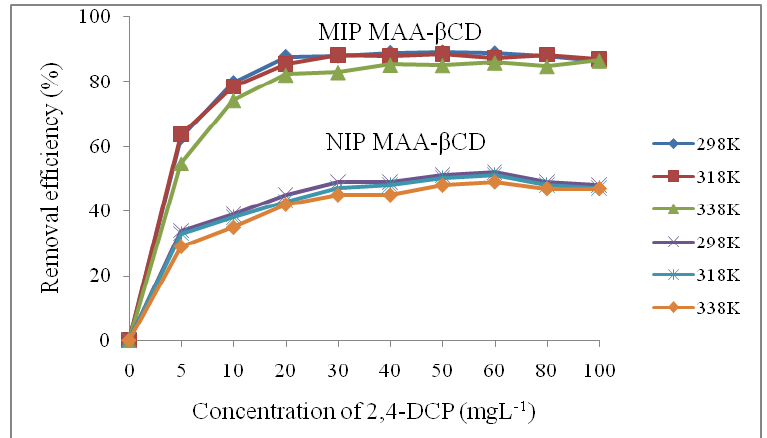
Figure 5. Effect of initial concentrations on the adsorption of 2,4-DCP onto MIP MAA-βCD and NIP MAA-βCD under different temperatures (Adsorption